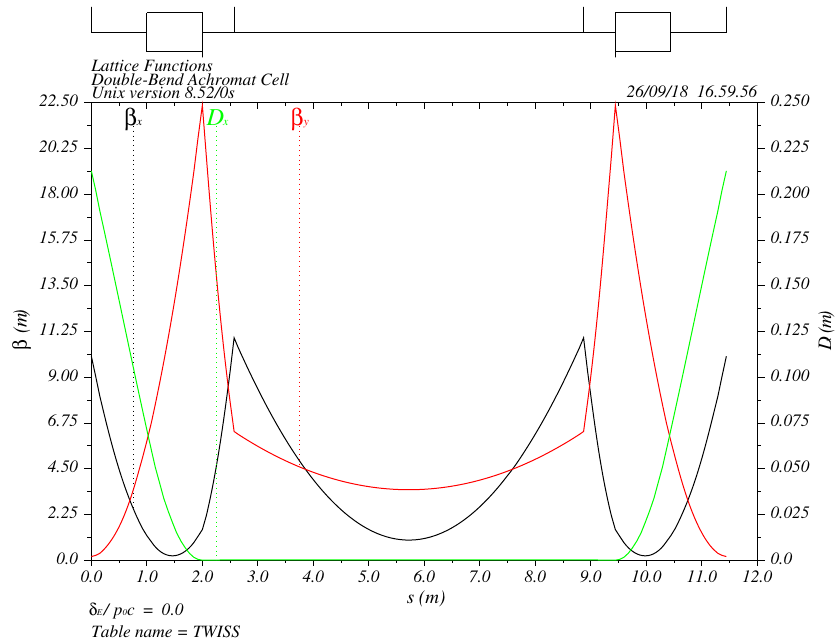
FIG. 6. Lattice functions of the DBA cell with parameters tabulated in Table